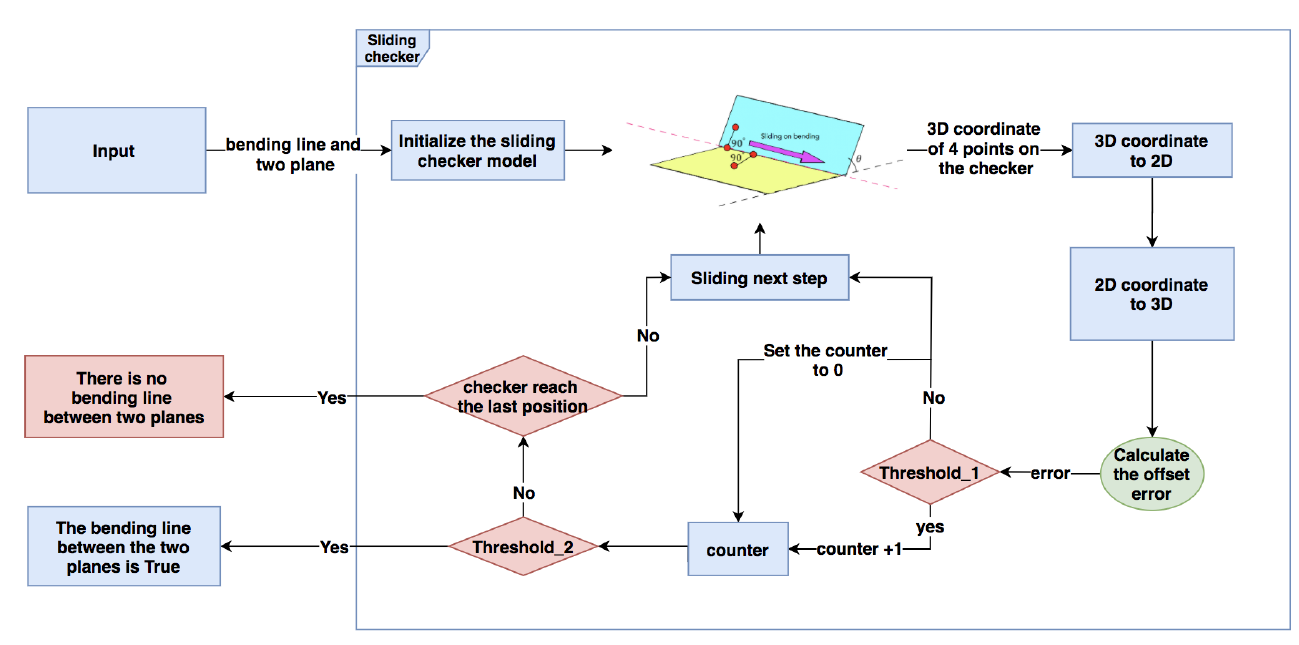
Figure 11. Apply Sliding checking model for bending line